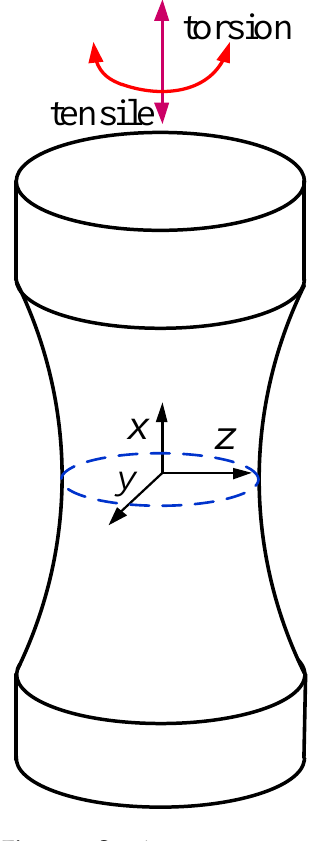
Figure 3. Specimen. Figure 3.